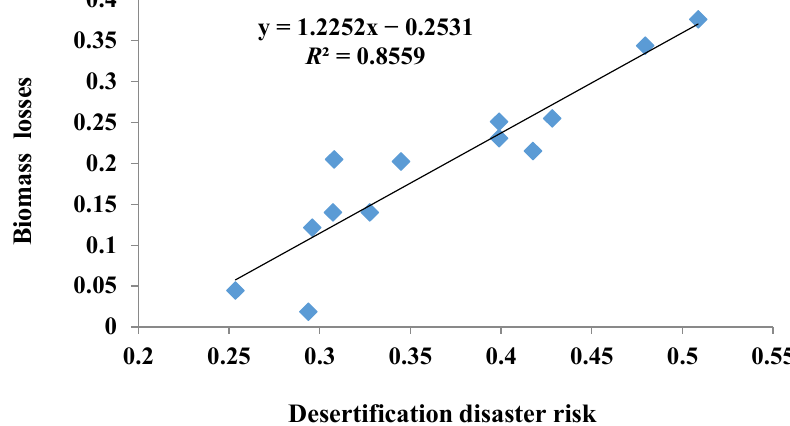
Figure 8. Comparing with the desertification disaster risk index and the biomass losses in Naiman